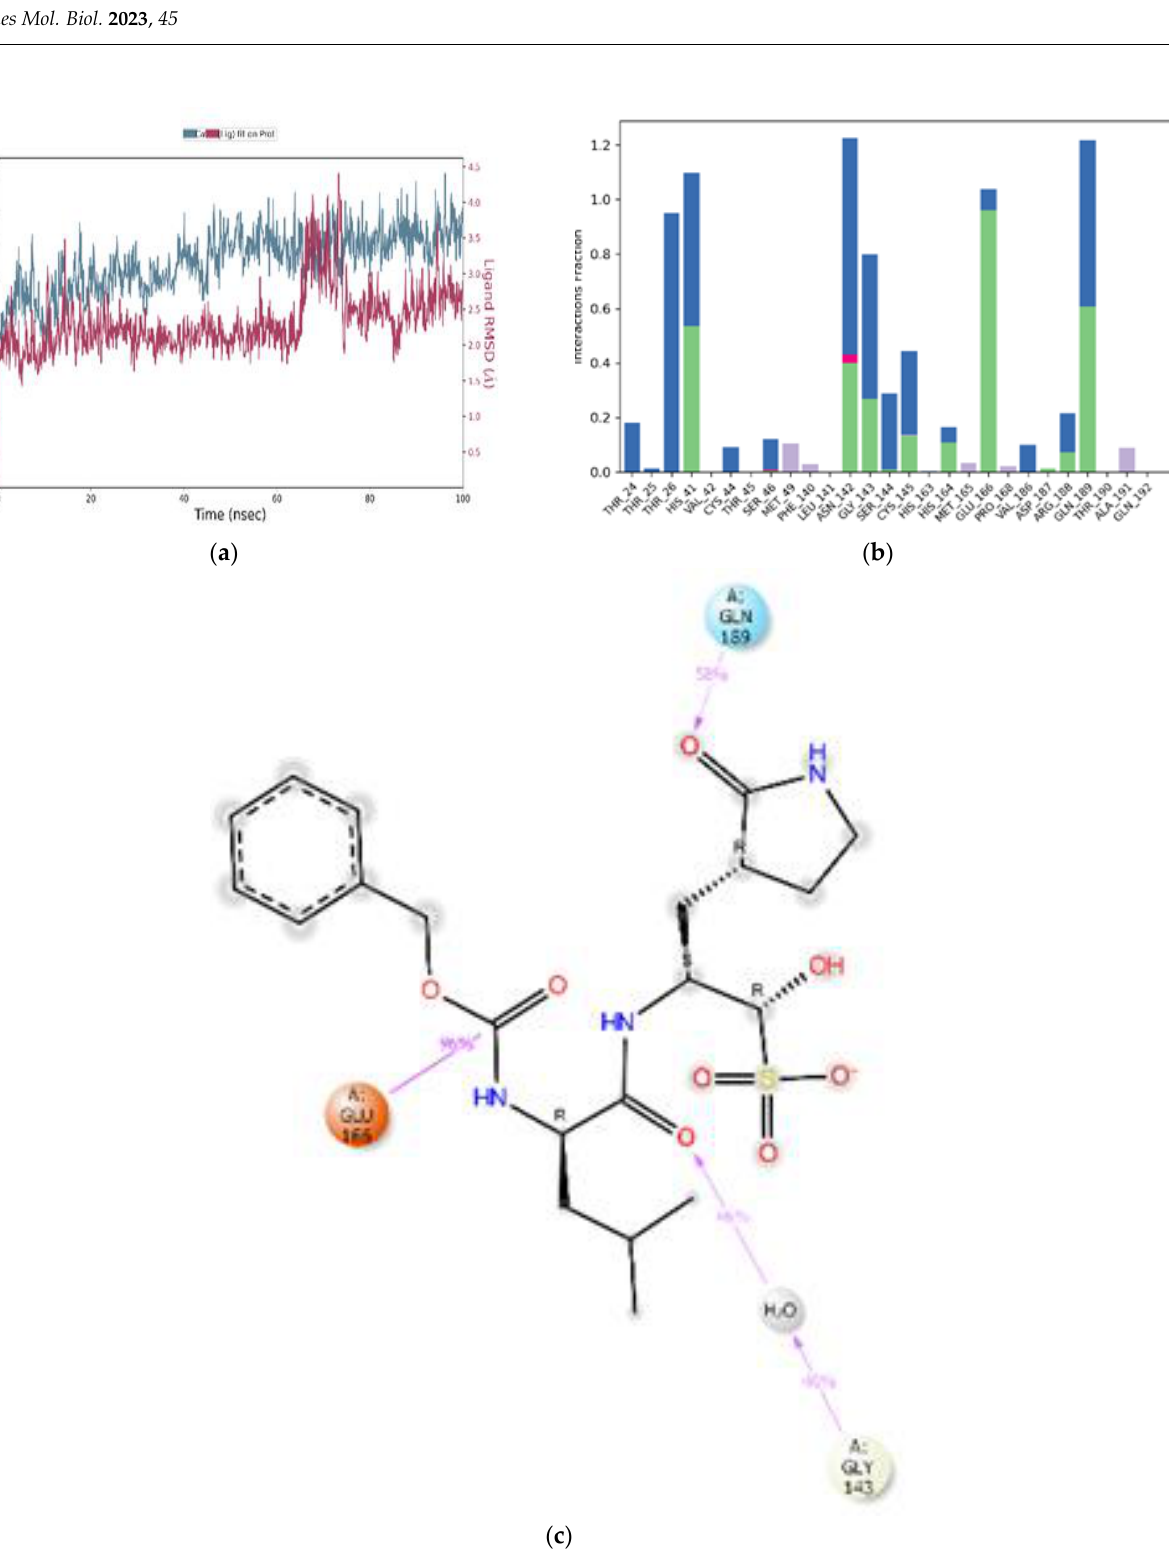
Figure 8. MD simulation studies of GC376 (Reference 1) in complex with M pro . RMSD plot of protein backbone (Cα) and protein conformational change during ligand binding ( a ). Interaction fraction plot showing different protein residues that interact with GC376 during a 100 ns MD simulation ( b ). Interaction of ligand atoms with the protein residues that occurs for >70% of the simulation time ( c ).